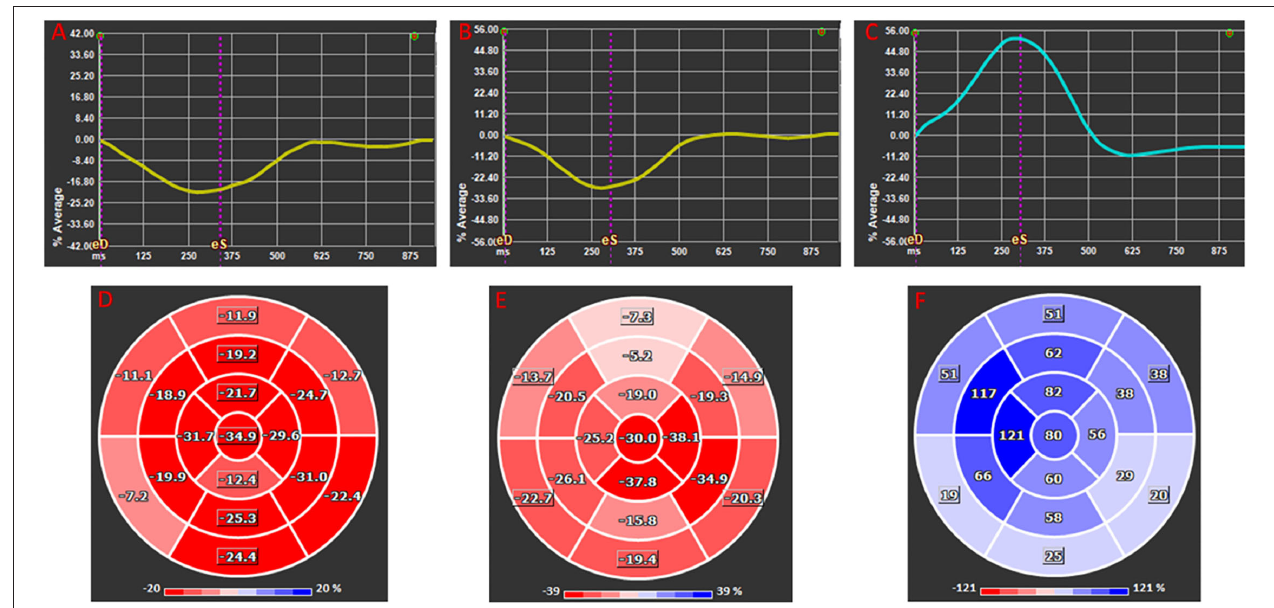
FIGURE 2 | Global longitudinal (A,D) , circumferential (B,E) , and radial (C,F) 2D strain presented as average global strain curves (A–C) and corresponding segmental strain according to American Heart Association 17 segments Bull’s eye ventricular maps (D–F) . Note that longitudinal and circumferential strains are negative at their peak as they represent decrease in in fiber dimension whereas radial strain is positive as it infers increased myocardial thickness.